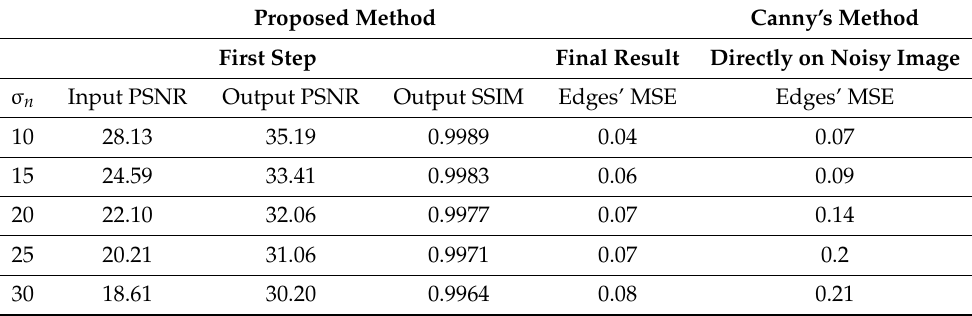
Table 1. Image Lena. A comparison of the results obtained for the proposed method and for Canny’s edge detector applied directly on the noisy image, for different values of noise standard